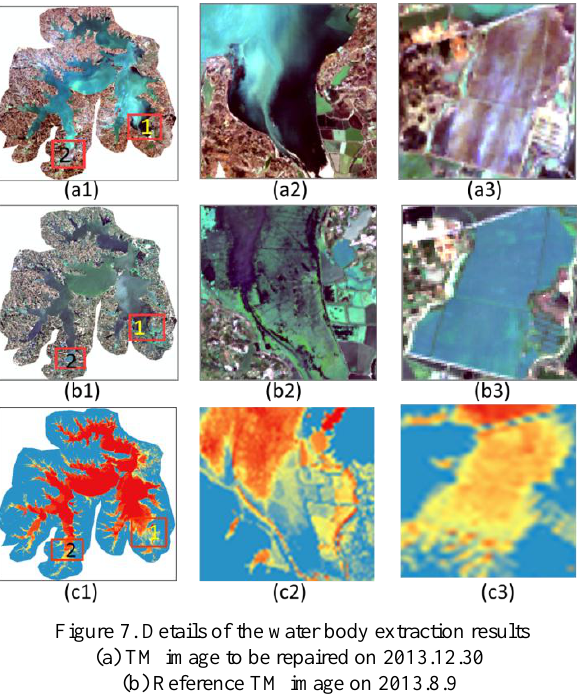
Figure 7. Details of the water body extraction results (a) TM image to be repaired on 2013.12.30 (b) Reference TM image on 2013.8.9 (c) Probability distribution map of water